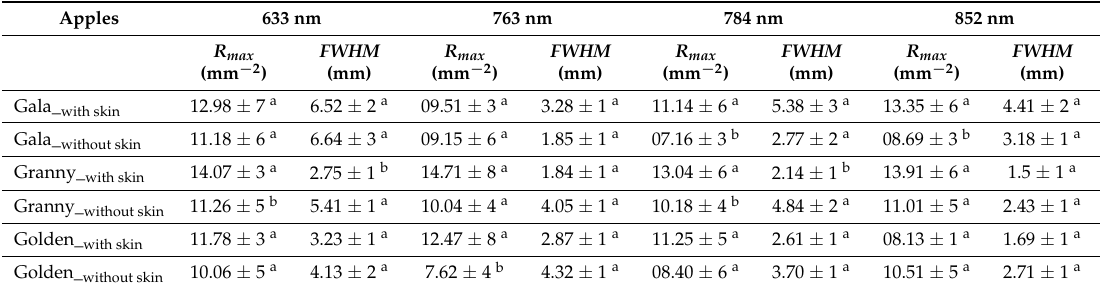
Table 1. Peak reflectance value ( R max ) and full-width at half maximum ( FWHM ) related to each studied apple cultivar.